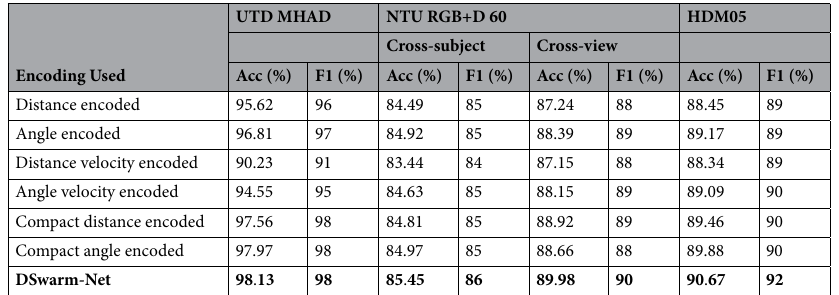
Table 2. Classification performance of the proposed DSwarm-Net model on three benchmark HAR datasets. Acc : Accuracy, F 1: F1-Score.